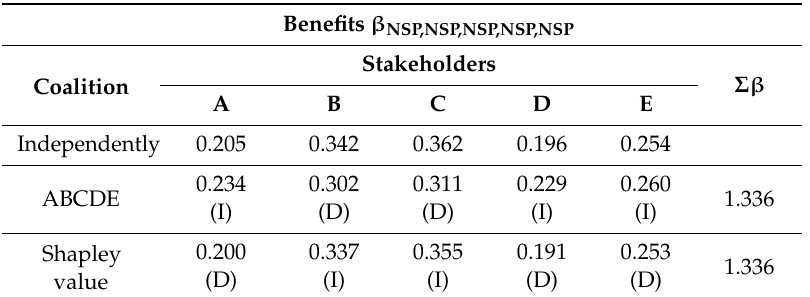
Table 15. Coalition distributions of benefits for stakeholders.